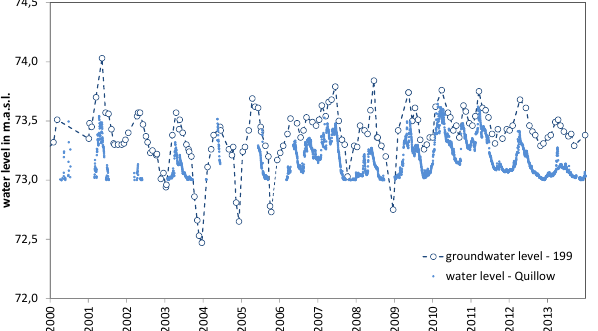
Table 3. The coordinates of well heads and positions of